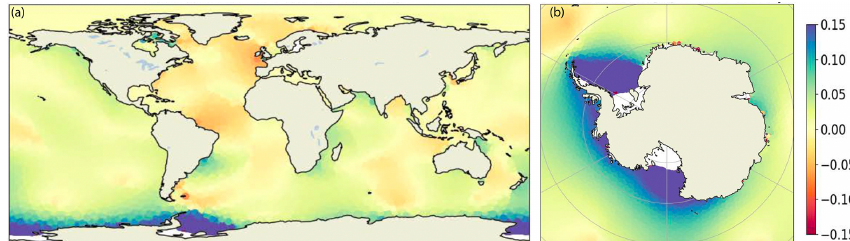
Figure 5. Difference in complex RMSE between Icos10 n and Icos10 is of (a) global and (b) South Polar projection. See Fig. 4f and g for